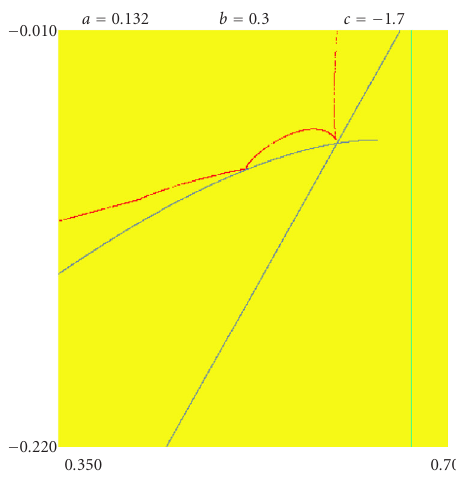
Figure 4.3. Creation of cusp points on the attractor, contact the cusp and the focal point.